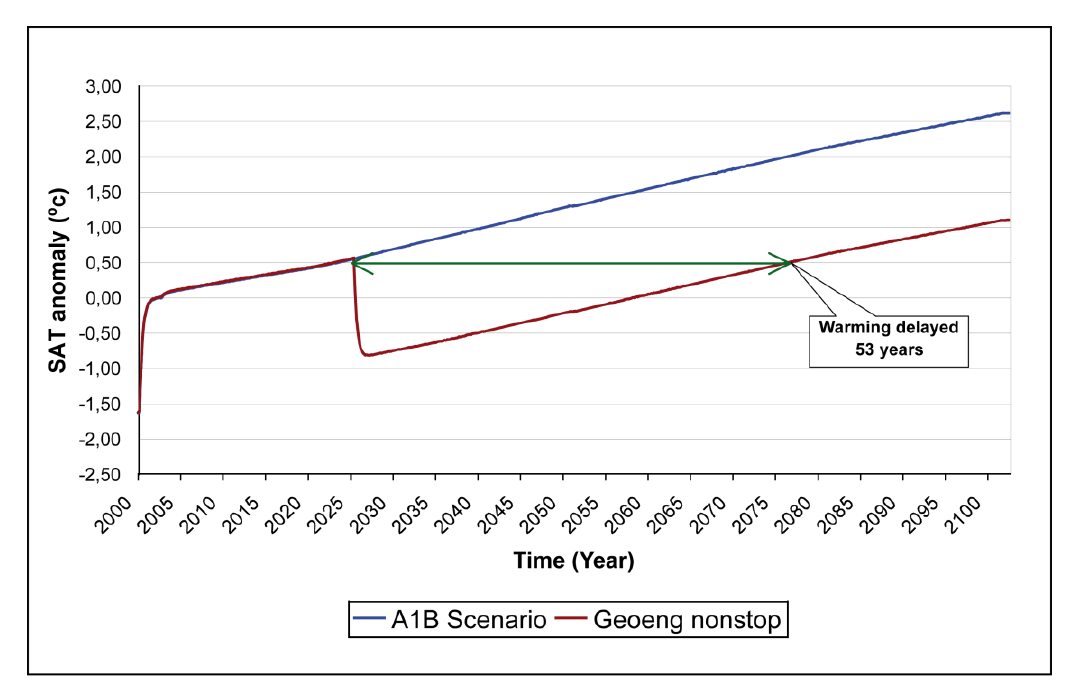
Figure 1. A1B scenario with a loading injected equivalent to Mount Pinatubo‘s